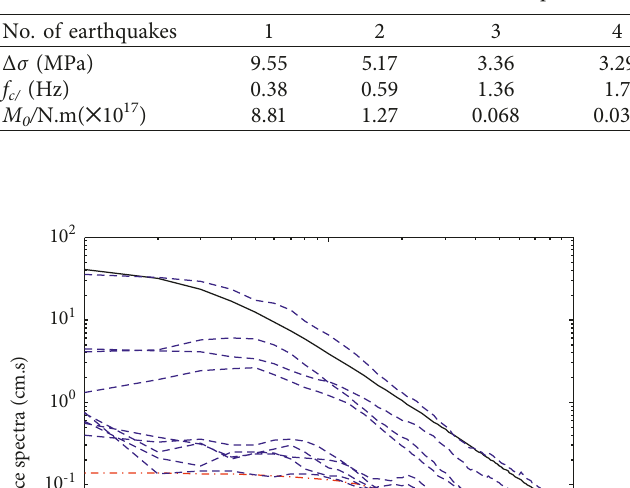
Table 2: Source parameters obtained in this study.